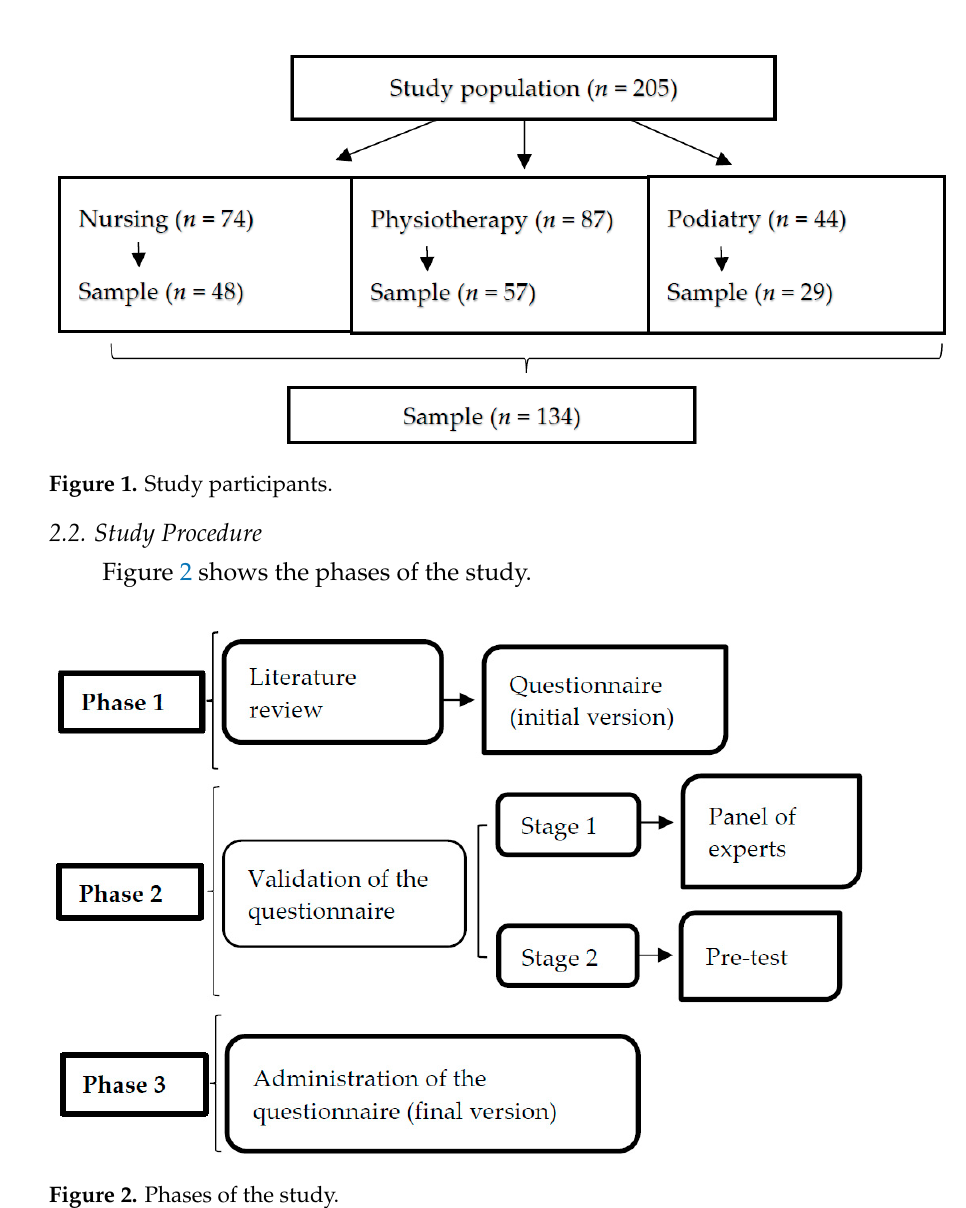
Figure 2. Phases of the study.